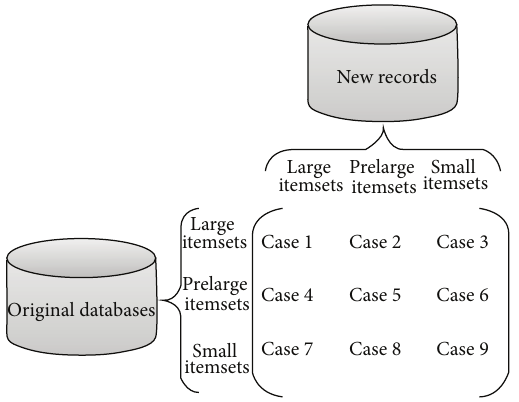
Figure 2: Nine cases arise as a result of transaction